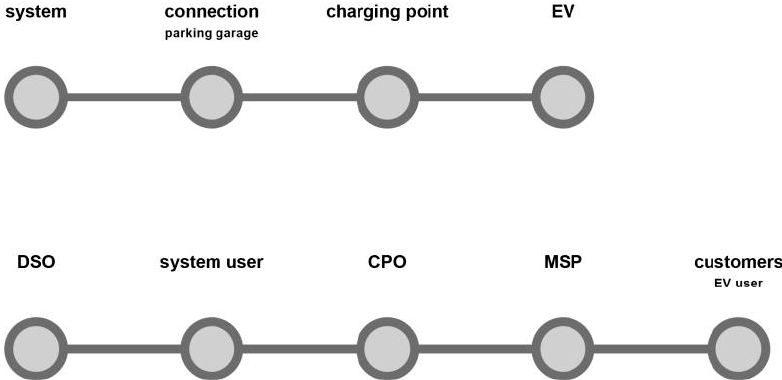
Figure 18. In this figure you can find the above described chain of relations. The upper sequence represents the ‘physical’ components as recognized by law, the lower sequence represents the actors.